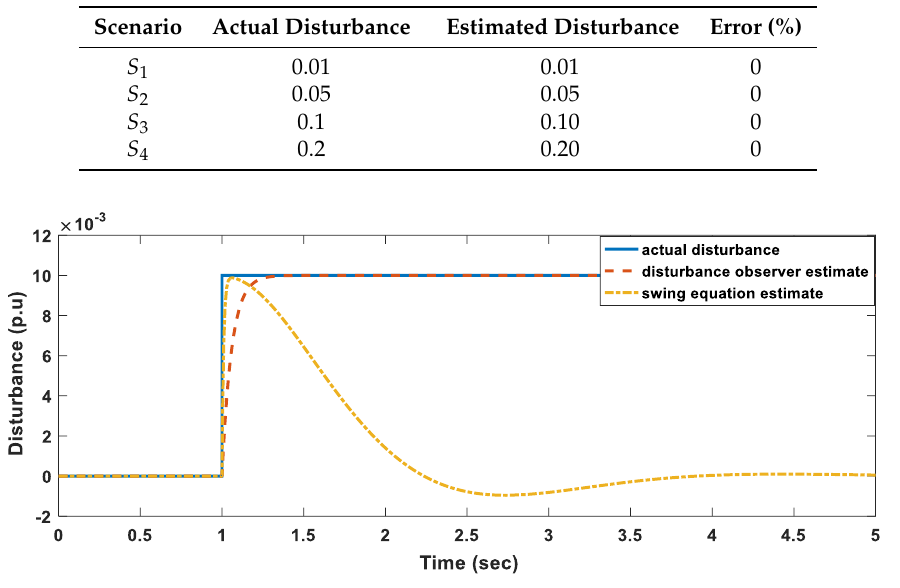
Figure 12. Scenario 1 disturbance observer vs swing equation